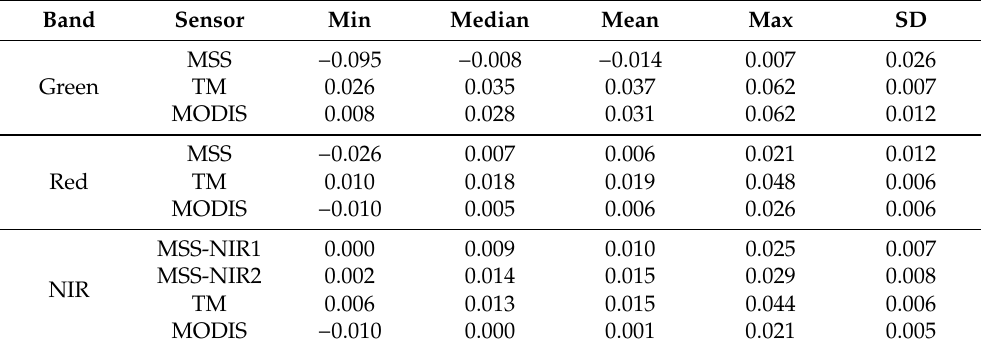
Table 7. Statistics of time-series reflectance of MSS, TM, and MODIS in ROI 1 (ROI 1: water body).